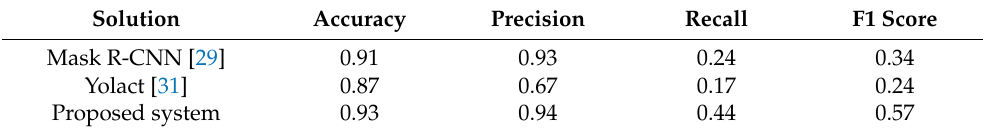
Table 2. Instance segmentation evaluation.